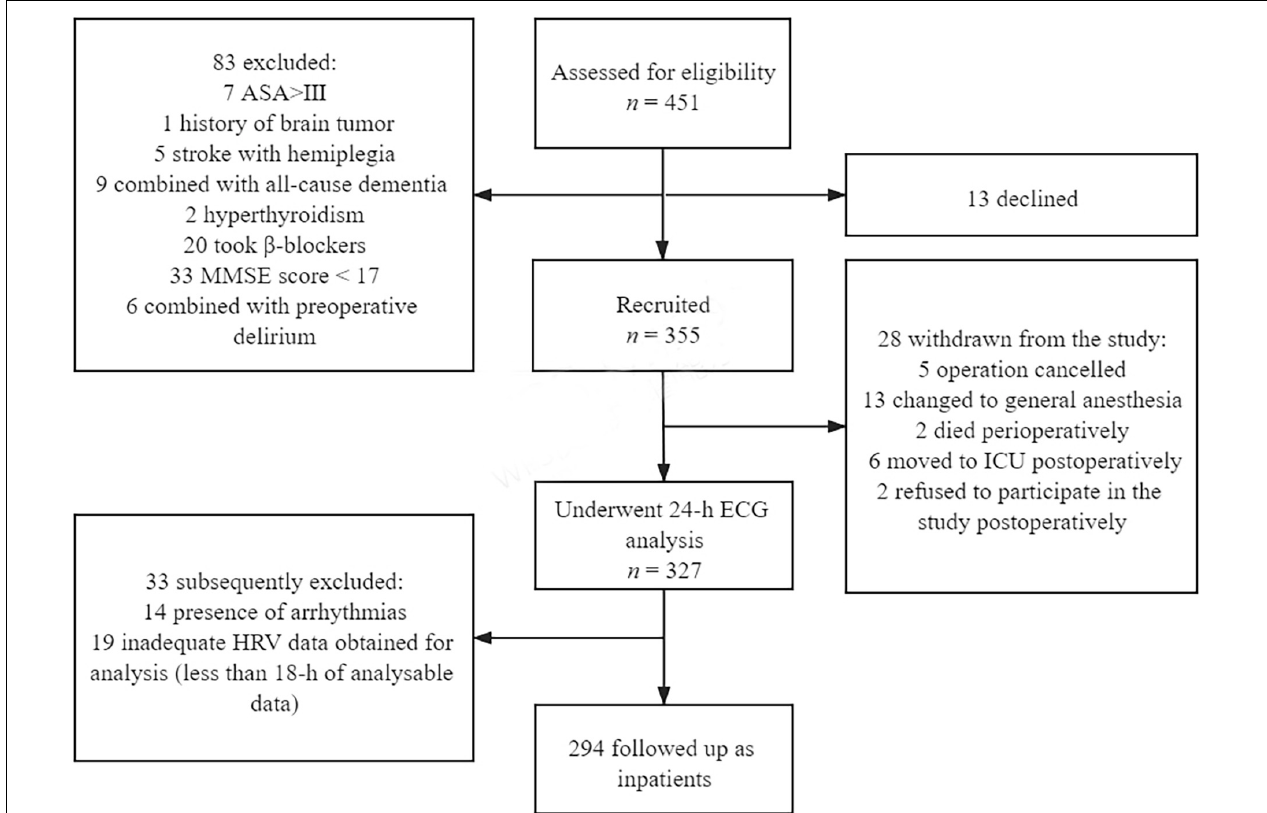
FIGURE 1 | Flowchart of the